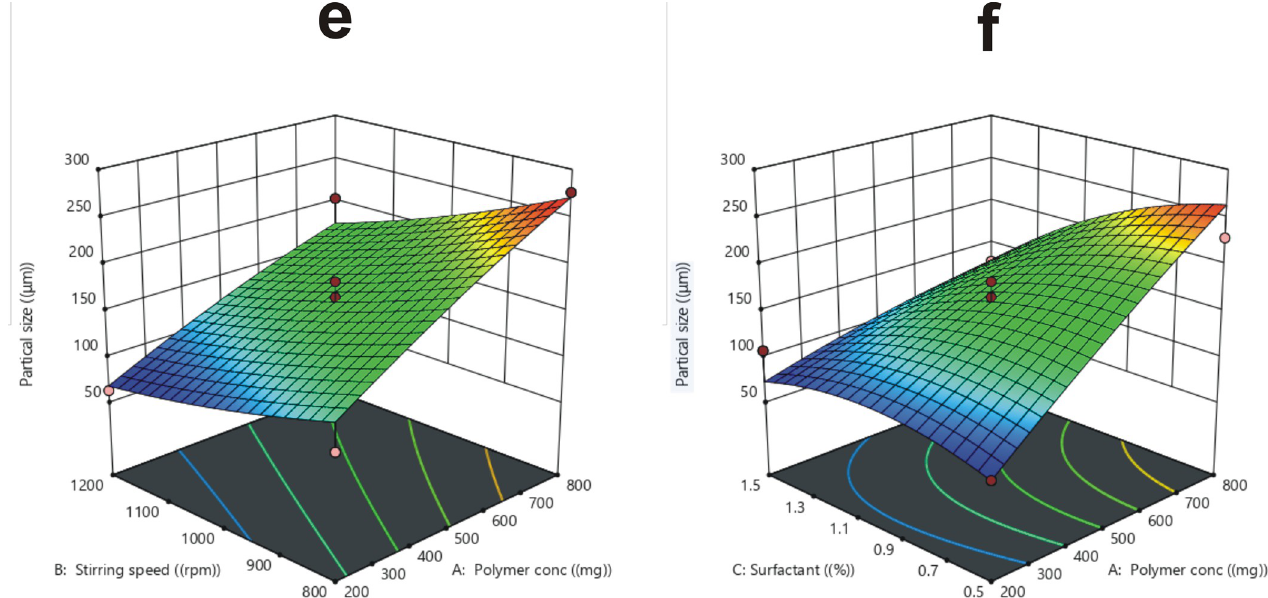
Fig 3. The influence of stirring speed and polymer concentration on particles size (e), the influence of surfactant conc and polymer concentration on particles size (f).